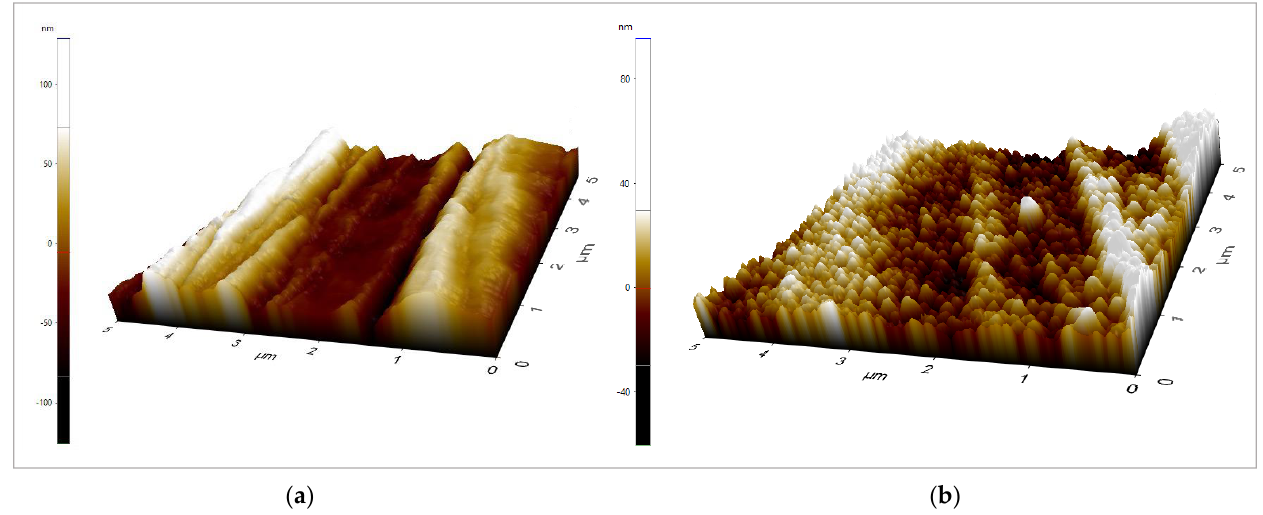
Figure 1. The surface topography of ( a ) 3 − YZP and ( b ) IC surfaces., areas of 5 µm × 5 µm were captured. The z scale bar ( a ) − 100 – 100 nm; ( b ) − 40 – 80 nm.